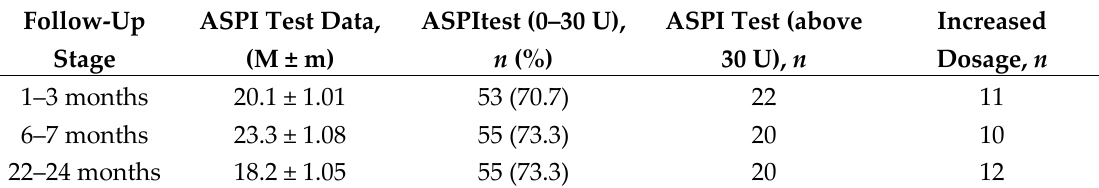
Table 1. The observation of ASPI test levels in patients with AIS ( n =